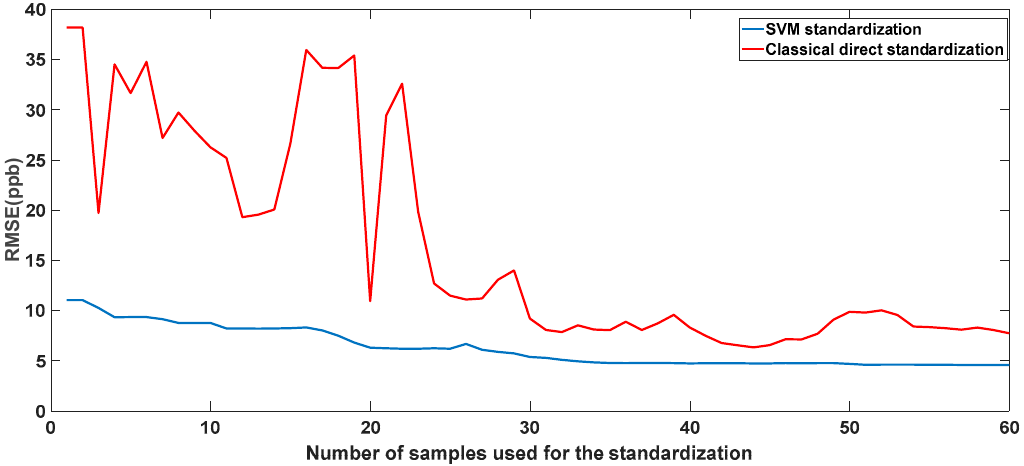
Figure 5. Evolution of the root mean square error (RMSE) prediction as a function of standardization sample number in two cases: classical direct standardization and SVM standardization.